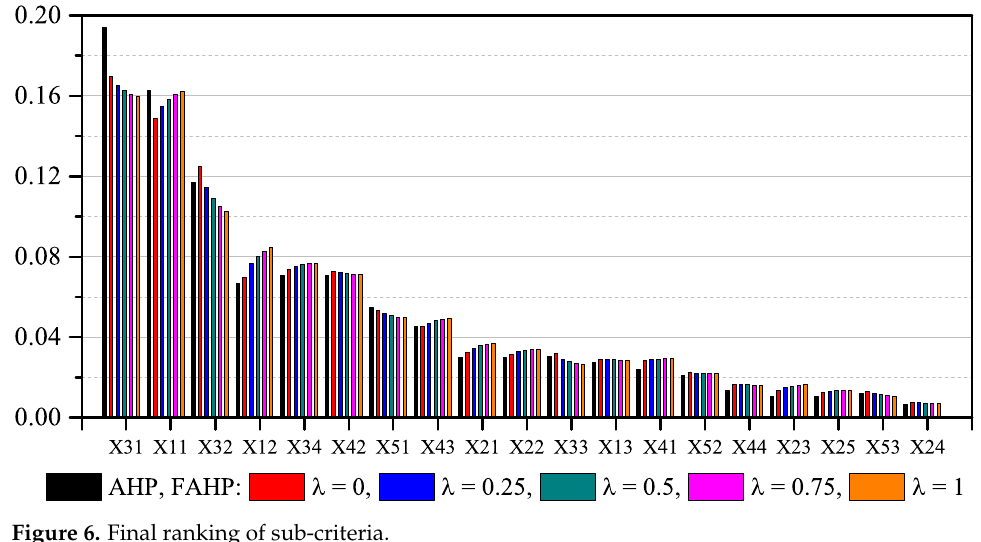
Figure 6. Final ranking of sub-criteria.